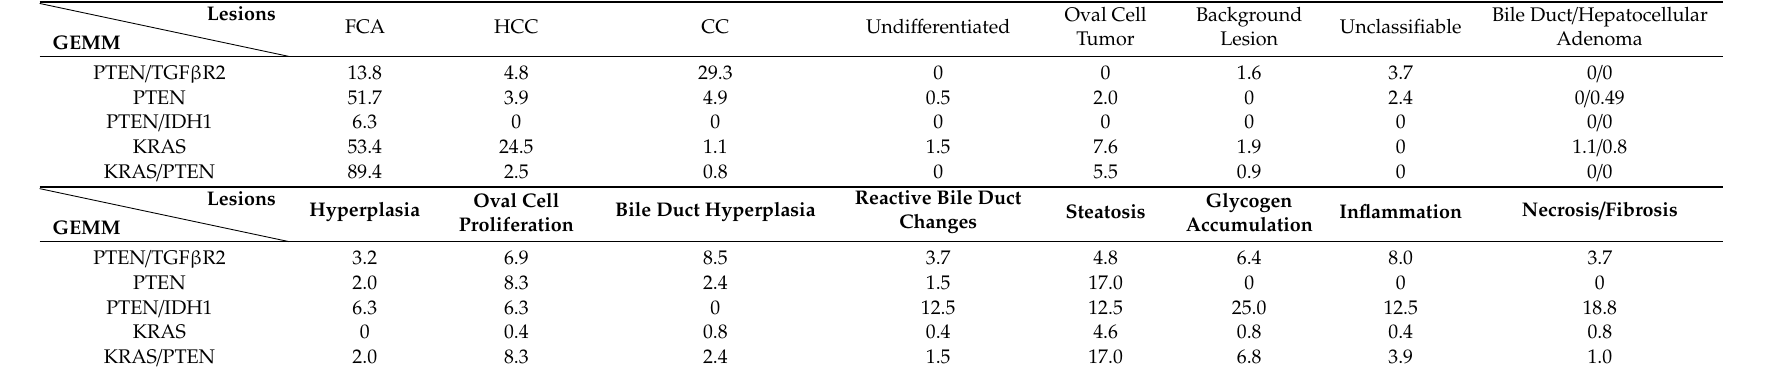
Table 1. Diagnosis and distribution of lesions in GEMM